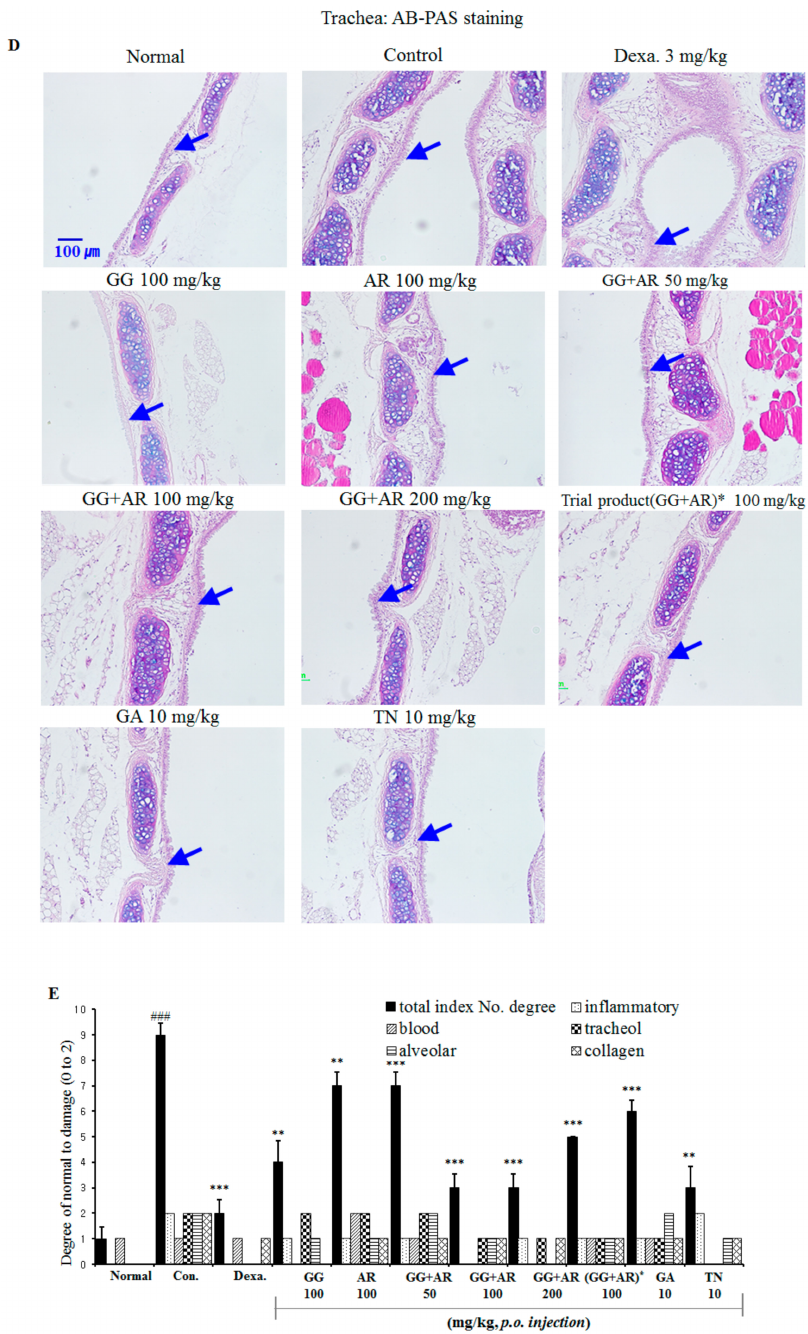
Figure 3. Inhibitory e ff ects of Glycyrrhiza glabra (GG), Agastache rugosa (AR), GG plus AR, glycyrrhizic acid (GA) and tilianin (TN) on histophathological markers of lung tissue of CFD-induced COPD model mice and drug-treated of each group. Representative H&E staining ( A ), M-T staining ( B ), PAS staining ( C ), AB-PAS staining ( D ), and quantitative analyses of the degree of lung tissue damage ( E ), which denote airway inflammation, subepithelial fibrosis, and goblet cell hyperplasia, respectively. Normal: normal group; Con.: CFD, CFD-induced COPD model group; Dexa.: CFD solution and administrated with dexamethasone 3 mg / kg group; GG 100: CFD solution and administrated with GG extract 100 mg / kg group; AR 100: CFD solution and administrated with AR extract 100 mg / kg group; GG + AR 50: CFD solution and administrated with GG plus AR extract 50 mg / kg group; GG + AR 100: CFD solution and administrated with GG plus AR extract 100 mg / kg group; GG + AR 200: CFD solution and administrated with GG plus AR extract 200 mg / kg group; GG + AR 100* (trial product): CFD solution and administrated with GG plus AR (trial product) 100 mg / kg